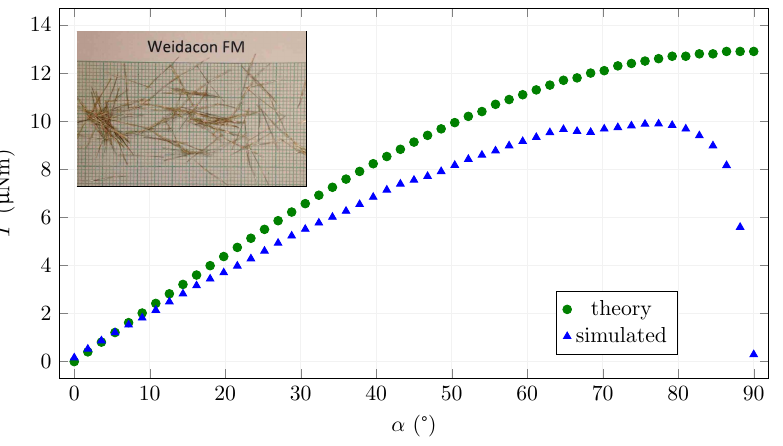
Figure 6. An example of the dependence of the mechanical torque acting on a saturated Weidacon FM fibre ( B fmax = 1.76 T) on the angle of rotation when the magnetic induction in the air around the fibre is B 0 = 25